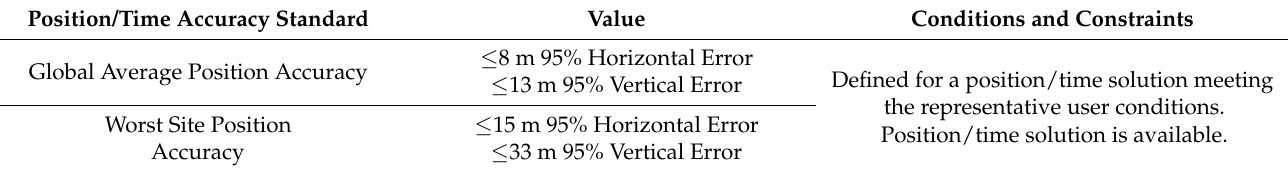
Table 3. SPS position accuracy standards according to